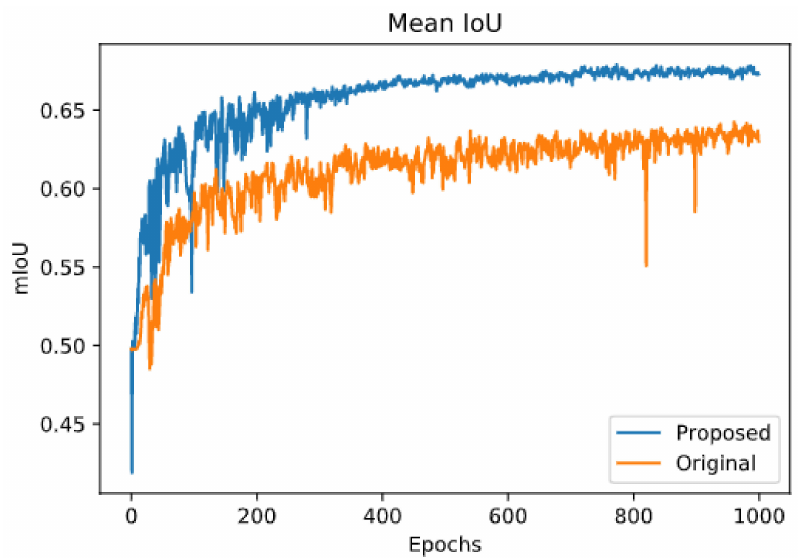
Figure 13. Comparison of the mean IoU (validation set) per epoch between the original and the proposed methods.